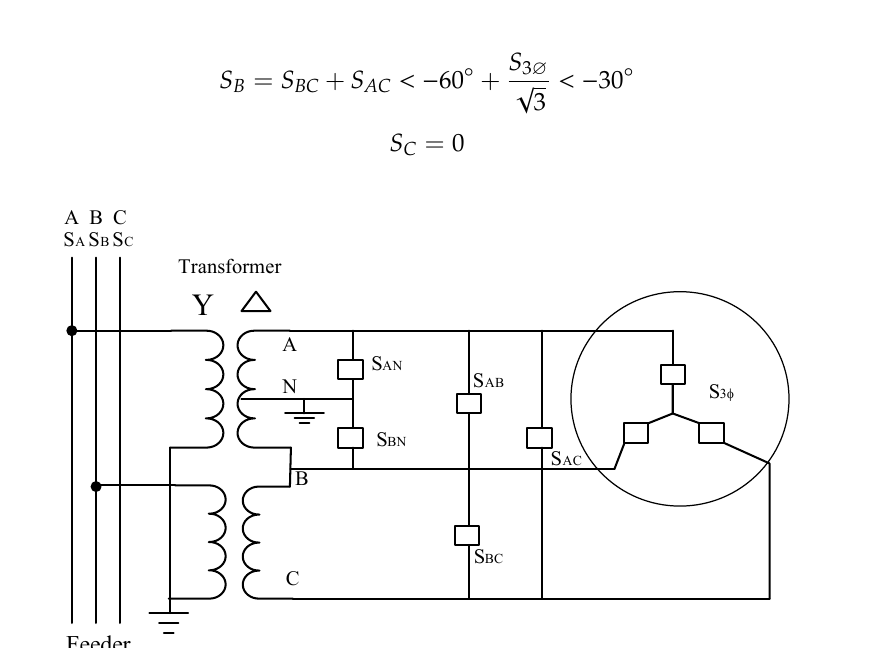
Figure 1. The loads of Open-Wye / Open Delta transformer. Table 1. The possible connection schemes of